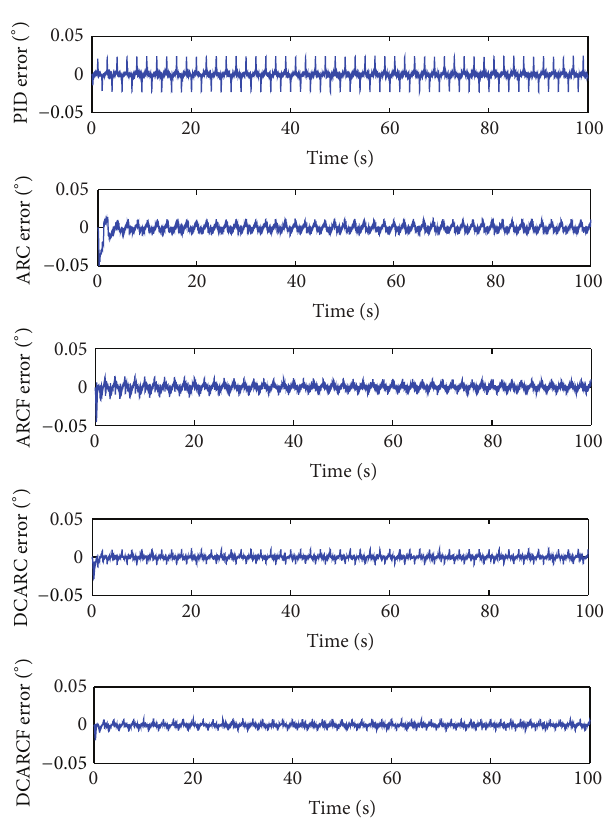
Figure 11: Tracking errors of five controllers in slow tracking case.